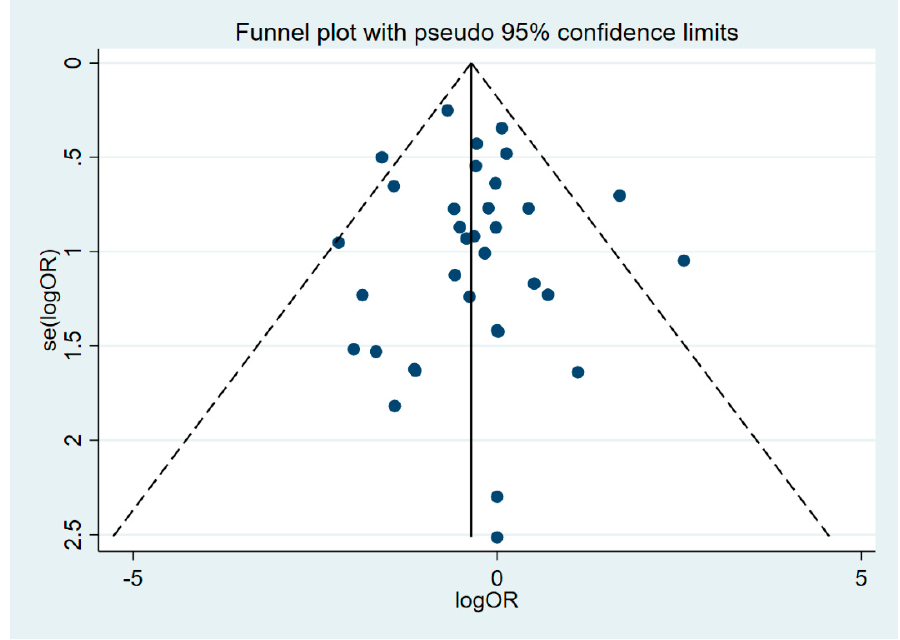
Figure 5. Funnel plot analysis. logOR, OR: Odds Ratio.